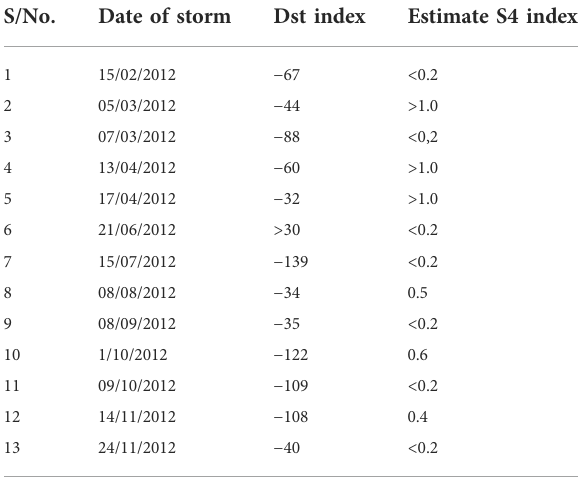
TABLE 5 Sampled dates of geomagnetic storm occurrences and corresponding estimate values of S4 indices.